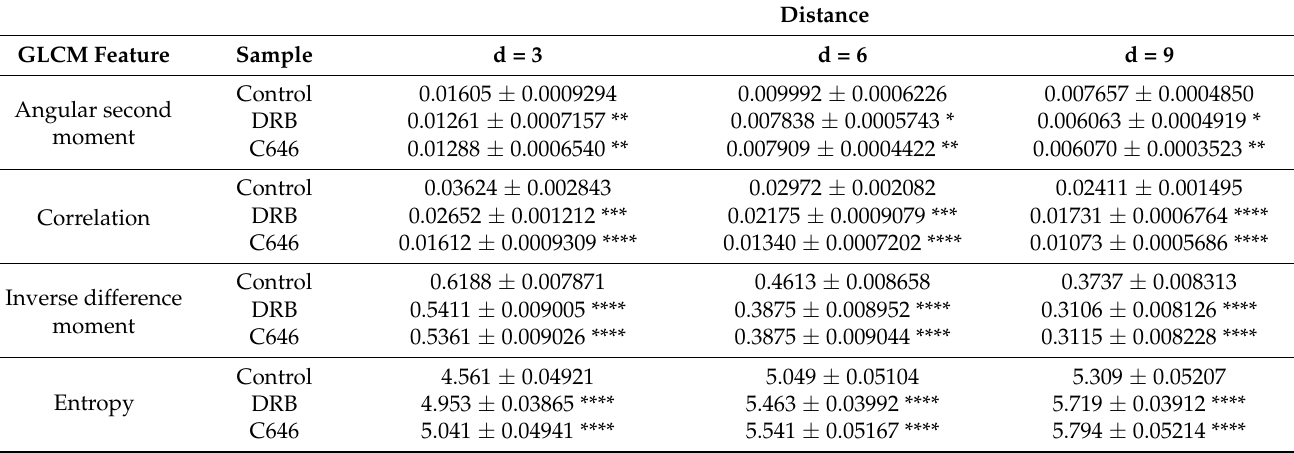
Table 2. Texture analysis of XPG immunofluorescence distribution after inhibition of transcription with DRB or